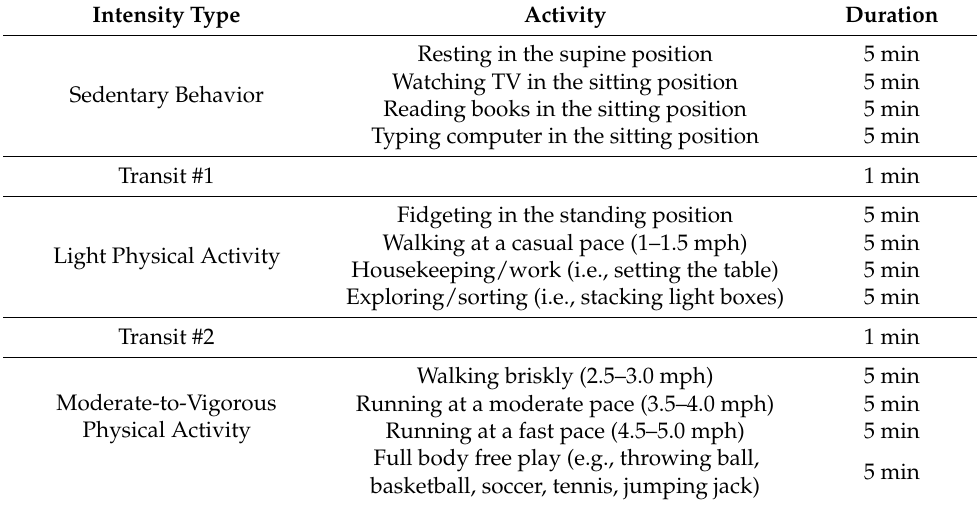
Table 1. Description of activities by